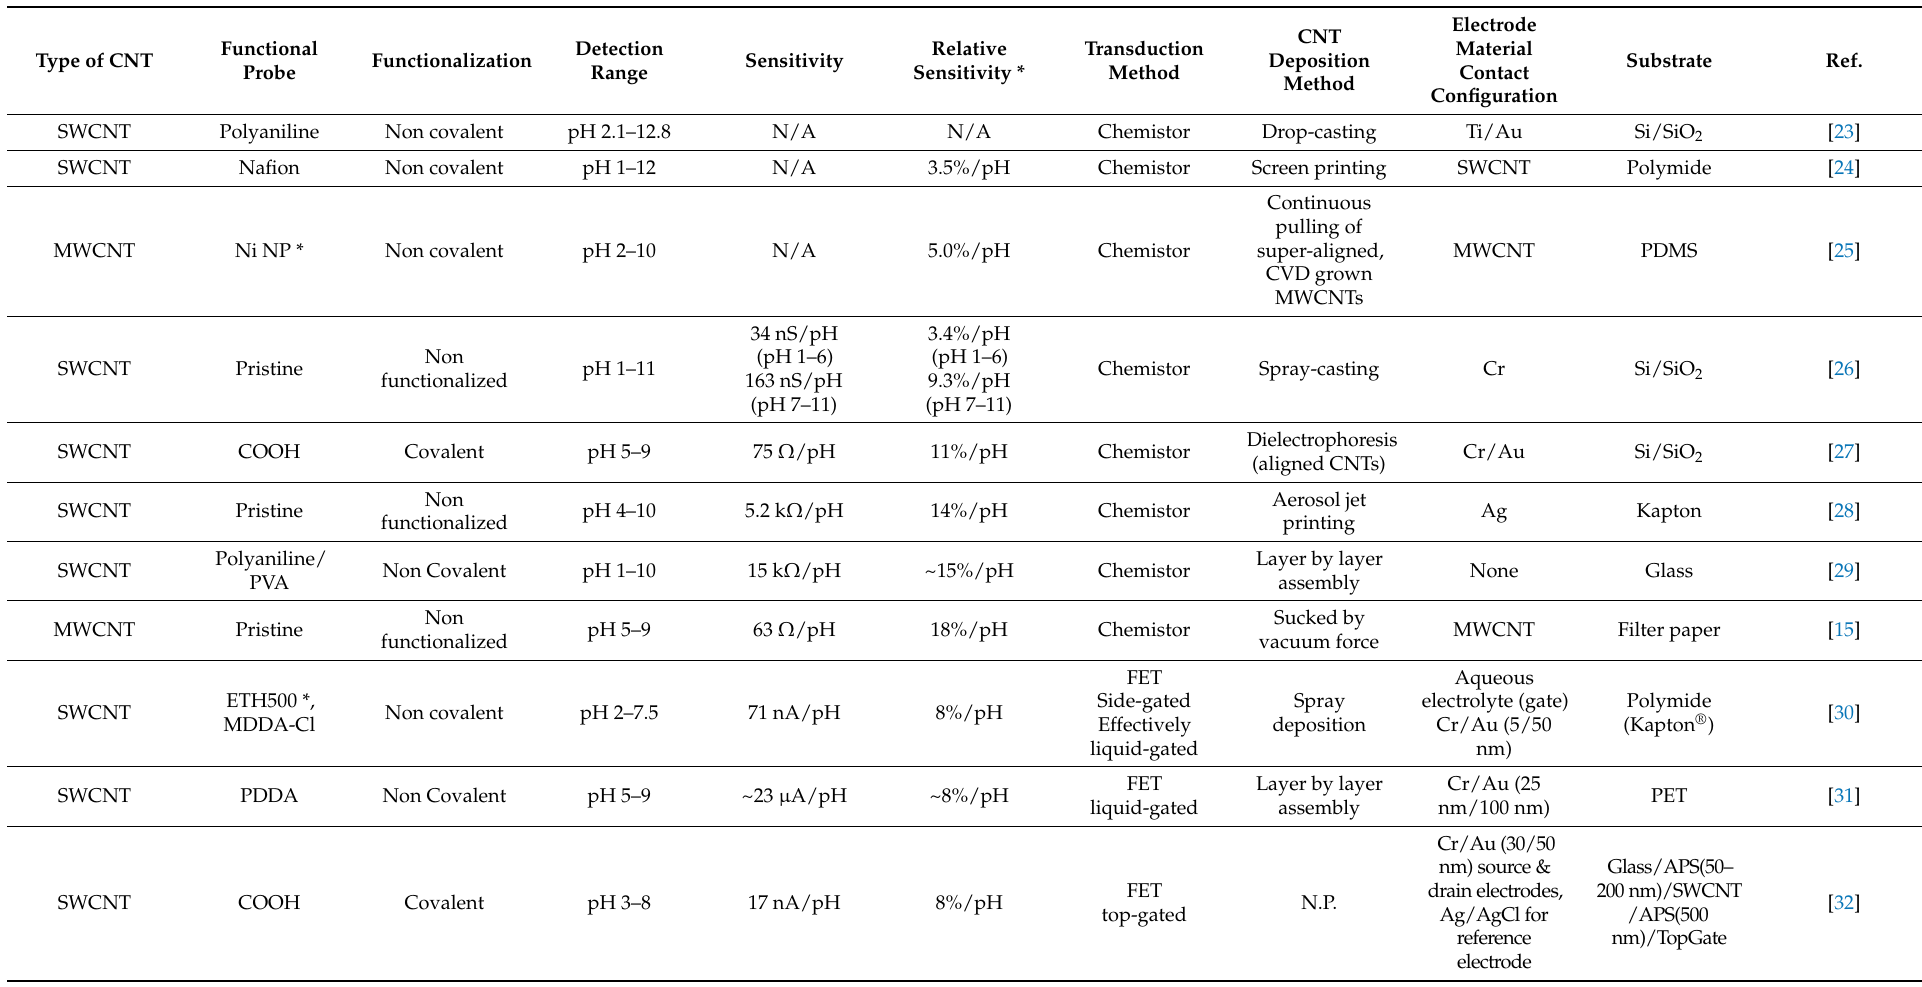
Table 1. CNT-based pH sensors in water, sorted by transduction type and then by relative sensitivity. Average relative sensitivities for chemistors and FETs are 11%/pH unit and 12%/pH unit, respectively. Expanded from